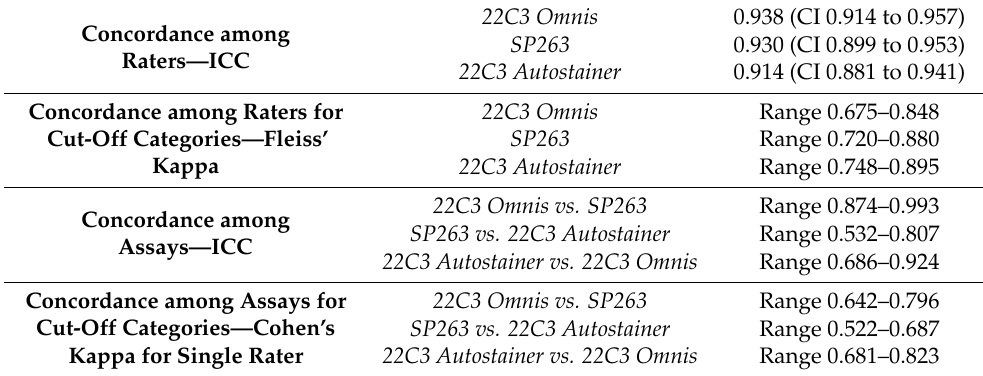
Table 2. Measure of